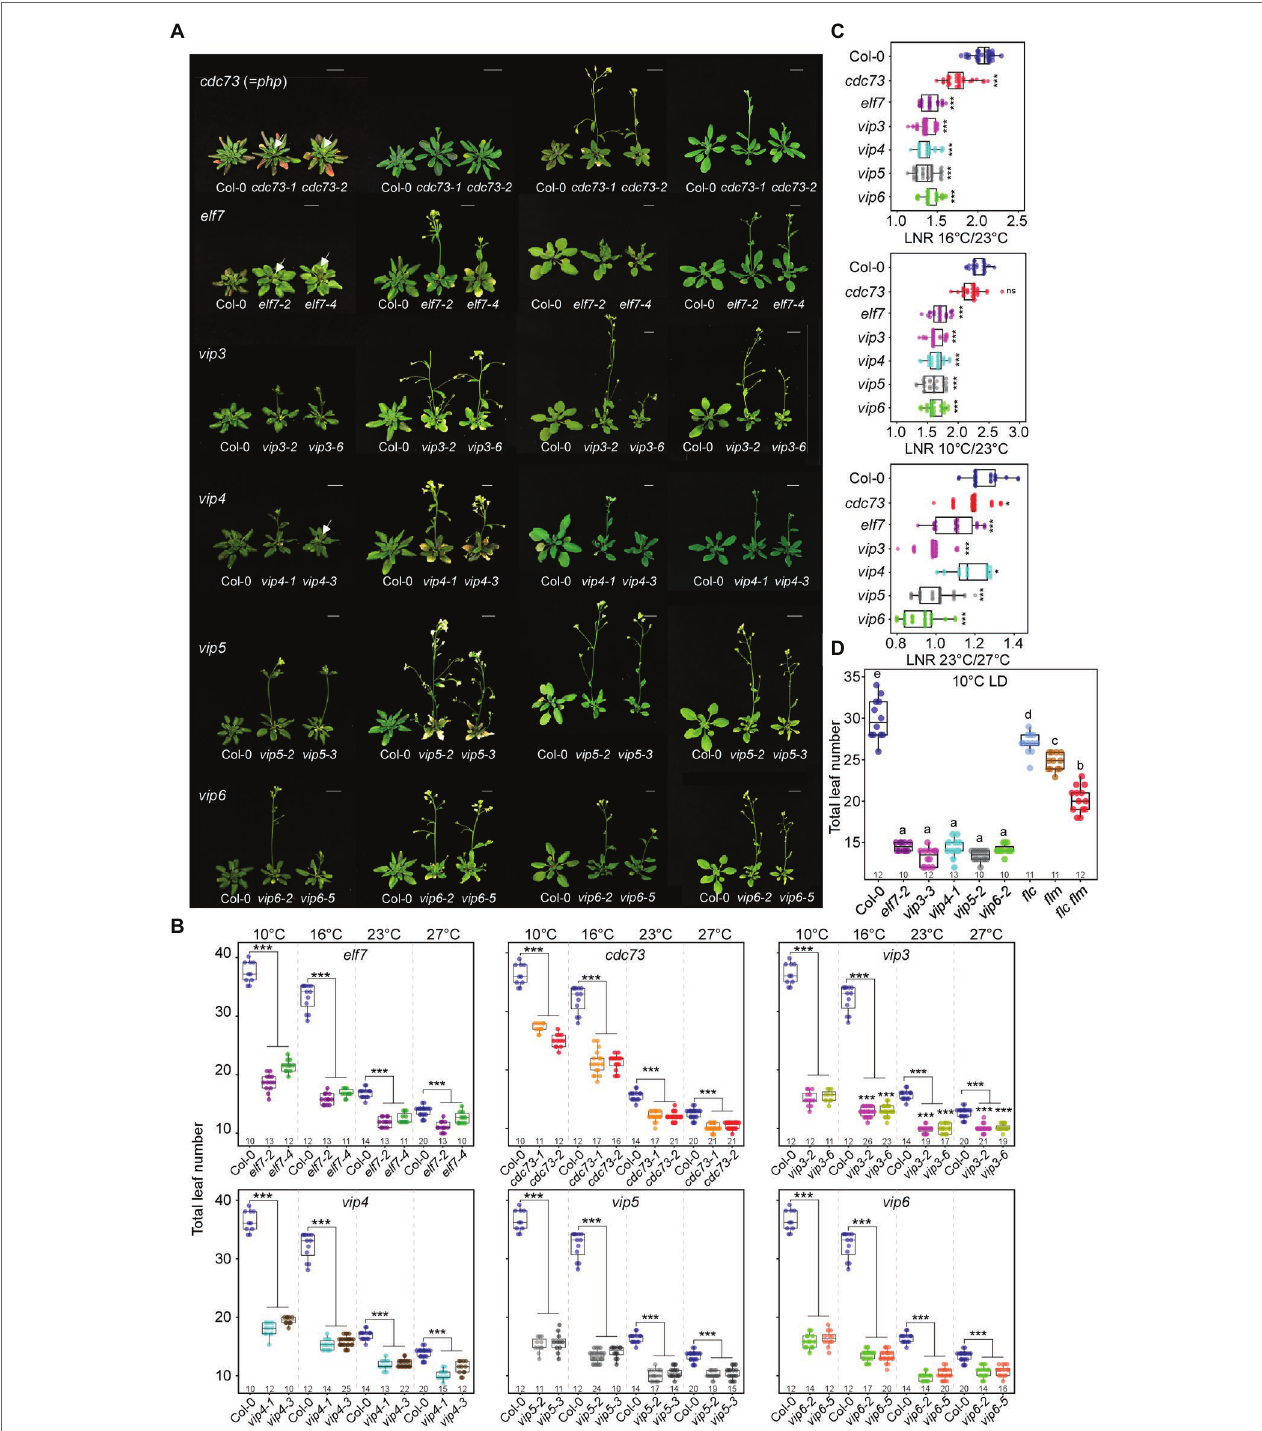
FIGURE 1 | Early flowering of polymerase II–associated factor 1 complex (PAF1C)-deficient mutants at all tested temperatures under long-day (LD) conditions. (A,B) Phenotype (A) and flowering time quantified as total leaf number (B) of PAF1C-deficient mutant lines at 10, 16, 23, and 27 ° C. Arrows indicate inflorescences. Note that the same leaf number data from Col-0 plants were used in each panel (B) . One-way ANOVA followed by Dunnett’s multiple comparison tests were performed to test the statistical significance. Scale bar = 1 cm. (C) Leaf number ratio (LNR) of Col-0 and PAF1C-deficient mutants. (D) Flowering time comparison of PAF1C-deficient mutants with flc , flm , and flc flm mutants at 10 ° C. One-way ANOVA followed by Dunnett’s multiple comparison tests were performed to test the statistical significance ( p < 0.05). * p < 0.05 and *** p ≤ 0.001. Letters in (D) indicate significant difference by one-way ANOVA followed by Tukey’s range tests Numbers above the x -axis represent n